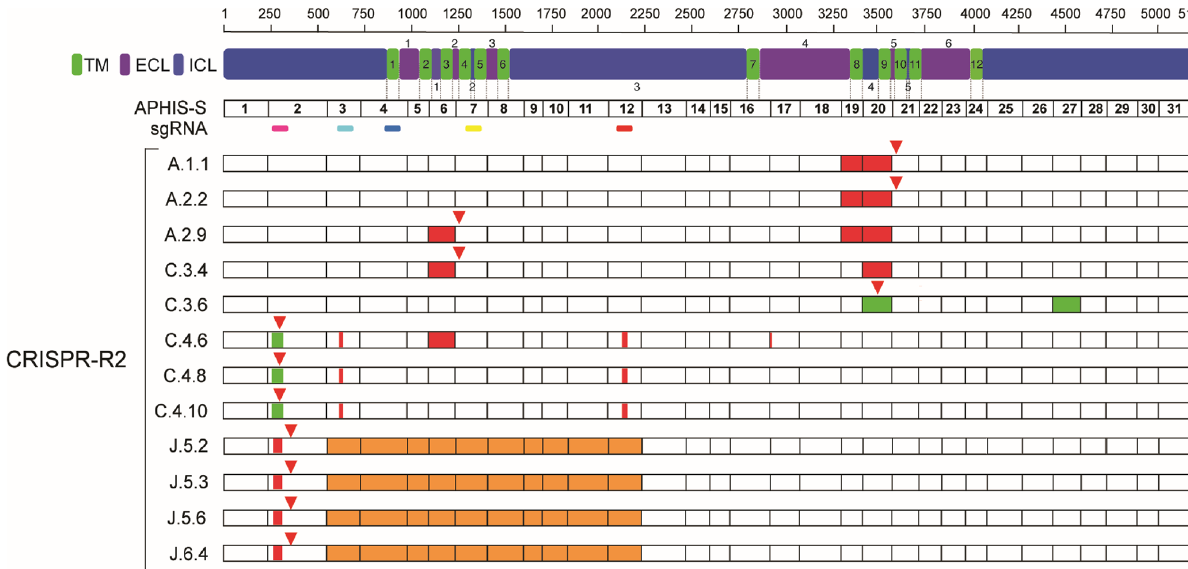
Figure 2. Mutations in 12 PgABCA2 cDNA sequences from six Cry2Ab-resistant pink bollworm larvae from F 2 progeny of CRISPR-R2 X APHIS-S single-pair families. Mutations in PgABCA2 cDNAs from CRISPR-R2 survivors from three single-pair families (1–3 clones from each of five individuals from families A, C, and J) relative to the susceptible strain APHIS-S (MG637361). Numbers to the right of the family name indicates individual and clone number, respectively (e.g., A.1.1 indicates Family A, Individual 1, Clone 1). Exon numbers are shown for APHIS-S. Location of sgRNAs 1–5 are shown as colored bars (sgRNA1, magenta; sgRNA2, cyan; sgRNA3, blue; sgRNA4, yellow; sgRNA5, red). Red triangles above bars indicate premature stop codons. Colors within bars show mutations: orange for insertions and deletions (indels), red for deletions, and green for